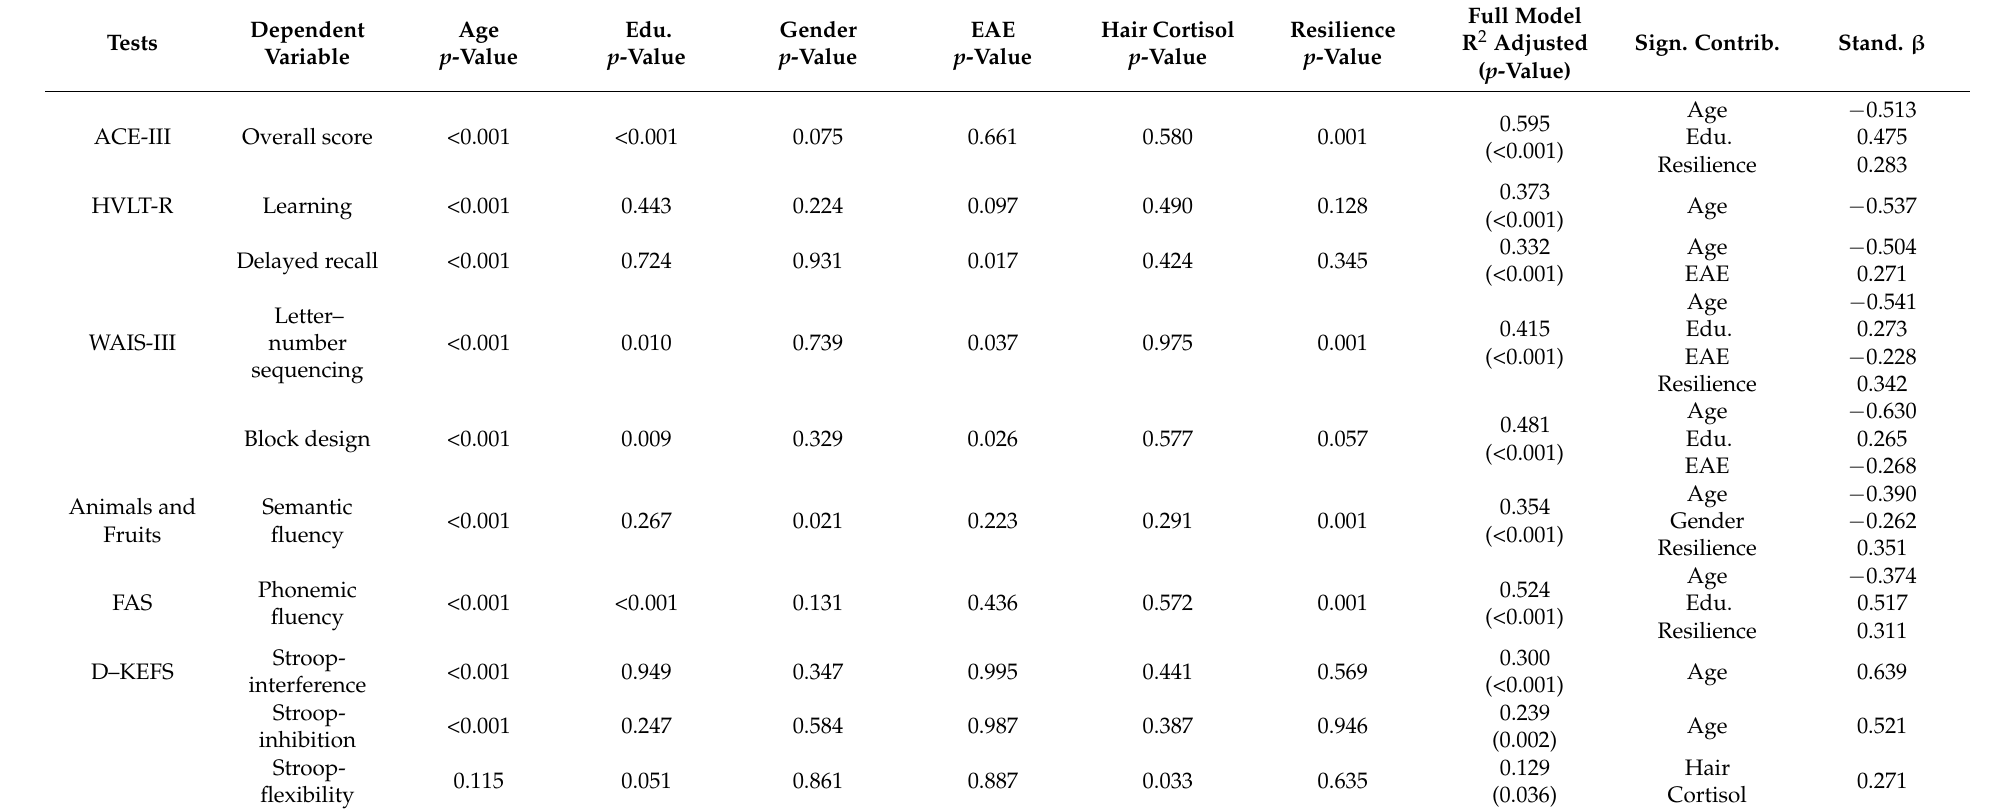
Table 2. Results of the multiple regression